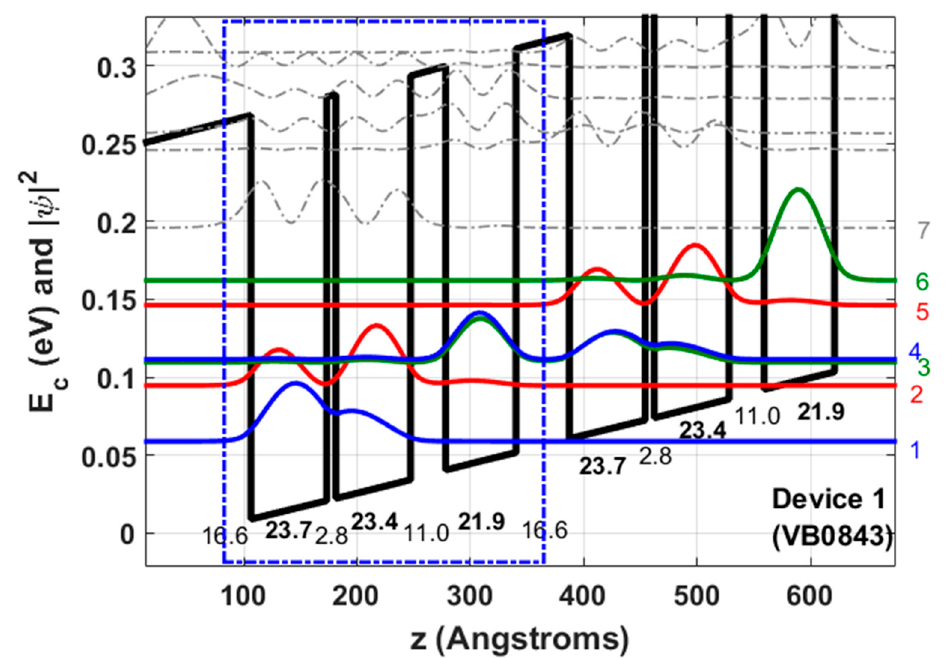
Figure 1. Band diagram of two sequential periods labeled module i (left, the dashed-dotted box) and module i + 1 (right) of Device 1 (wafer VB0843). In the figure there are various distortions of the wave functions (different shape and amplitude of wavefunctions for the same levels) due to the presentation of only two periods. The two periods are preferred by us due to presentation considerations.